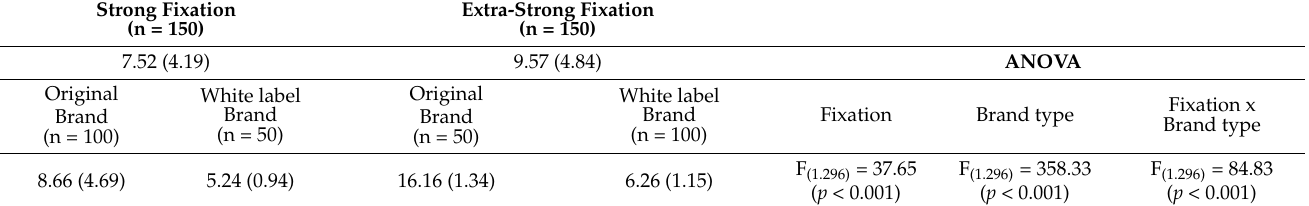
Table 4. Comparisons of the adhesive retention by fixation and brand type.